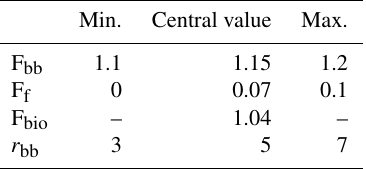
Table 1. The range of input values for crucial parameters used in the Monte Carlo simulations: the fraction modern of biomass burning aerosol (F bb ) , the fraction modern of fossil-dominated sources (F f ) , the fraction modern of biogenic aerosol (F bio ) , and the OC / EC ratio of domestic biomass combustion ( r bb ) . These values are based on critical evaluation of the literature as discussed in Sect. 2.9. Min. Central value